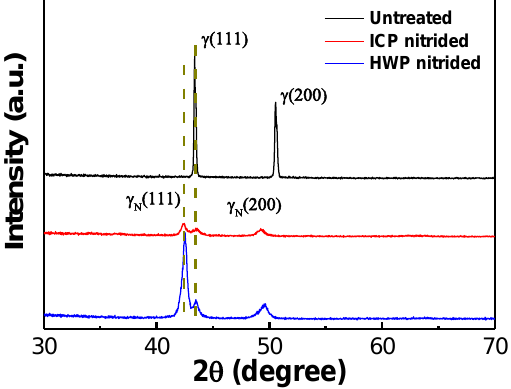
Figure 4. XRD patterns of Samples S1 – S3.